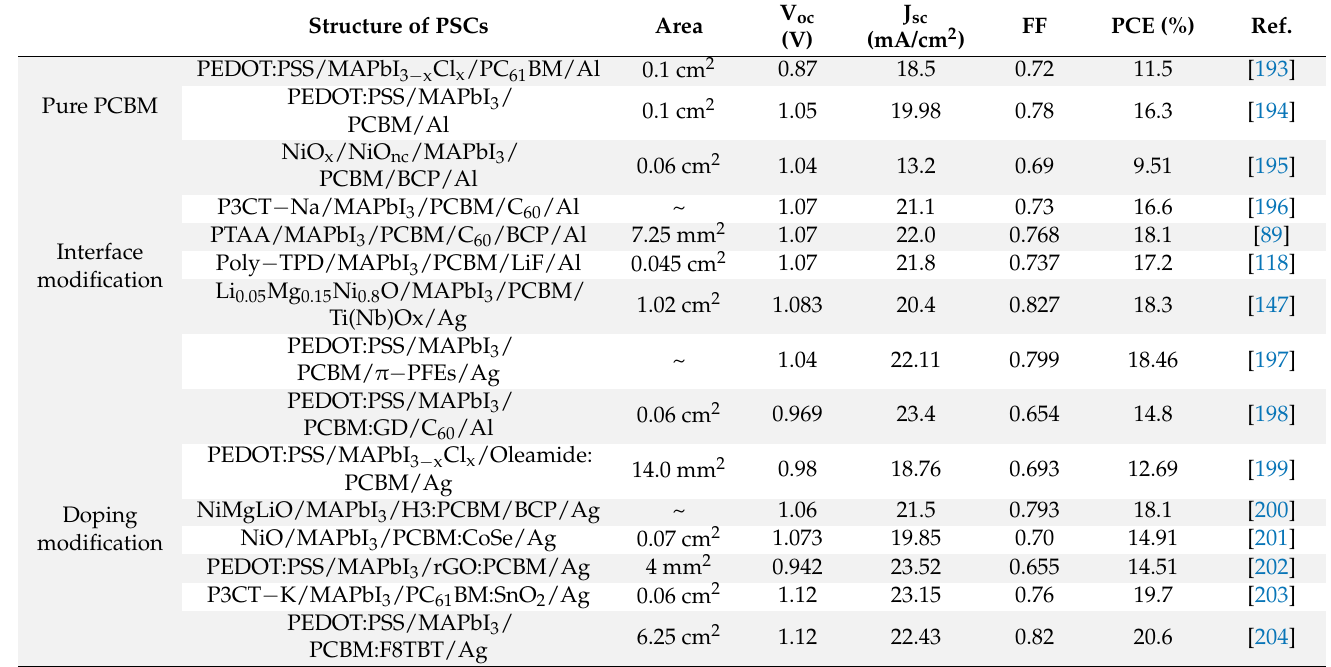
Table 17. Performances of several representative inverted PSCs on the basis of C 60 and C 60 − derivatives